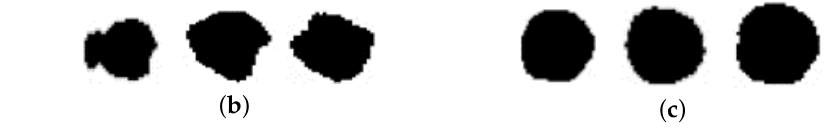
Figure 2. Examples of ( a ) Type III nodules presenting deformities and elongated shapes, ( b ) Type V nodules presenting slight deviations from circular shapes, and ( c ) Type VI nodules resembling circles with little to no deformities.